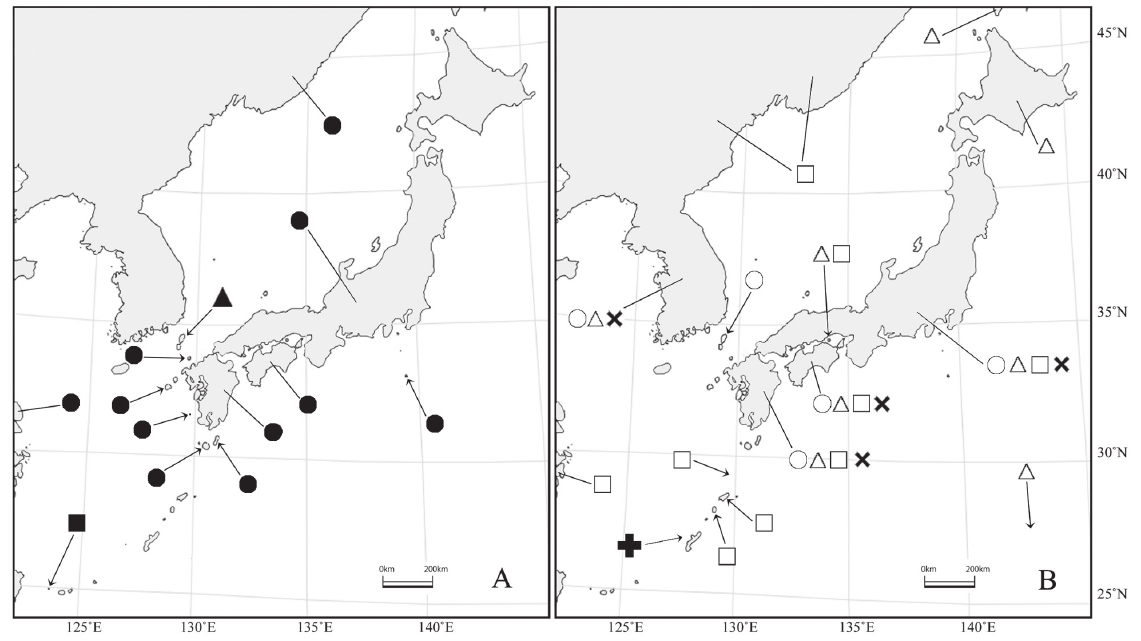
Fig. 11. Map showing the distribution of Intybia spp. A . The histrio group: ●: Intybia histrio (Kiesenwetter, 1874), ▲: I. tsushimensis (Satô & Ohbayashi, 1968), ■: I. donan sp. nov.). B . The pelegrini